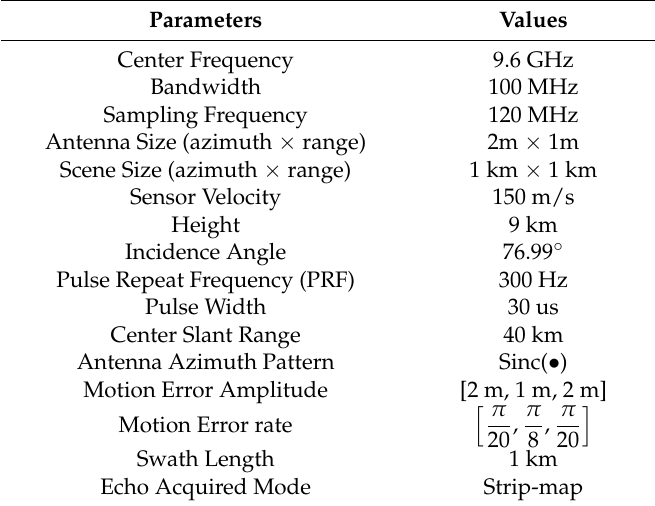
Table 1. Simulation parameters of the intensive accelerated motion error.